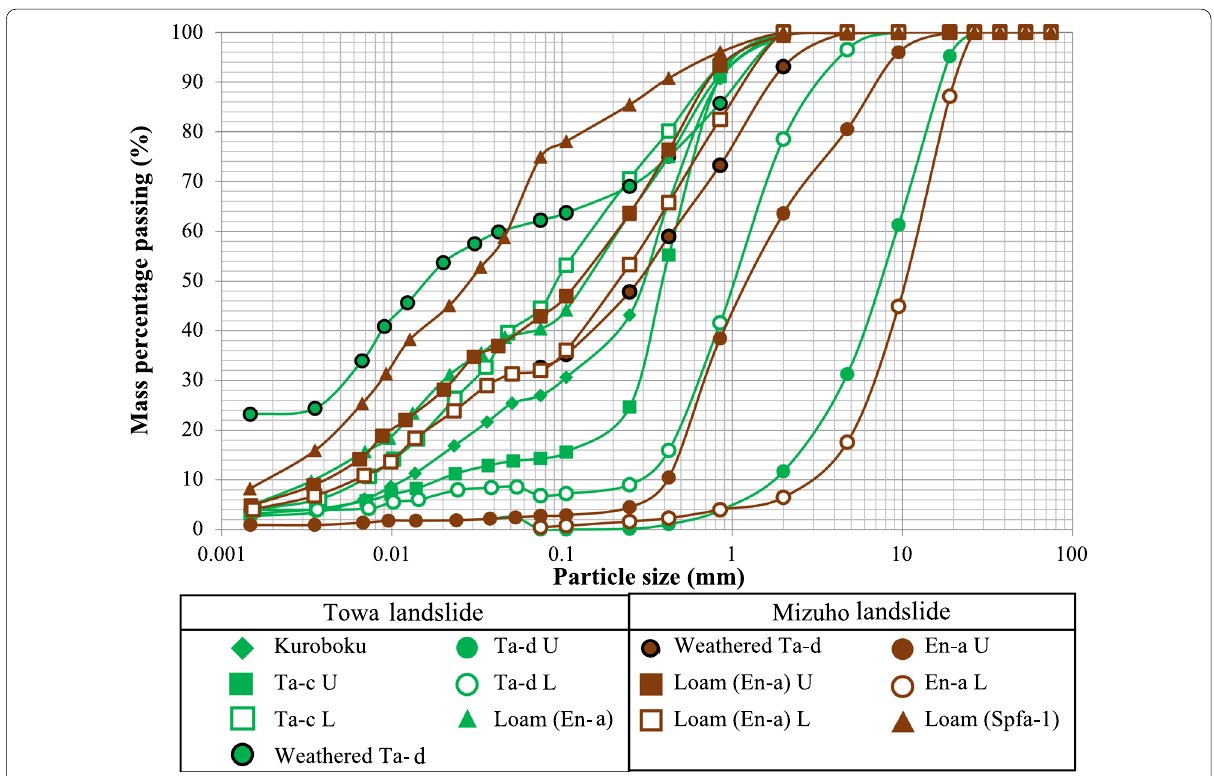
Fig. 6 Particle size distribution curves of tephra